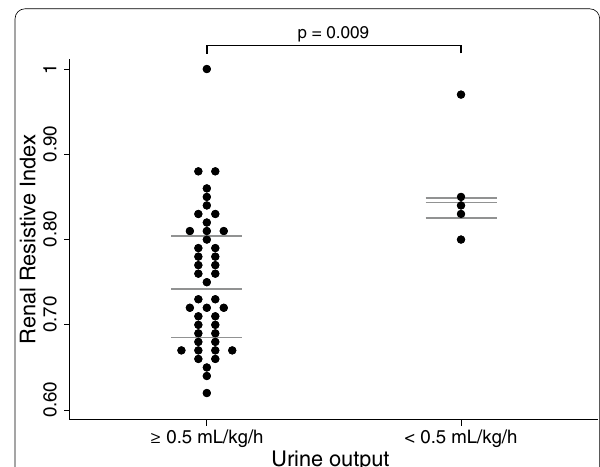
Fig. 4 Dot plot illustrating the association between renal resistive index and oliguria defined as urine output < 0.5 ml/kg ideal body weight/hour for 24 h. Each dot represents a patient. The horizontal lines represent the median, upper and lower quartiles